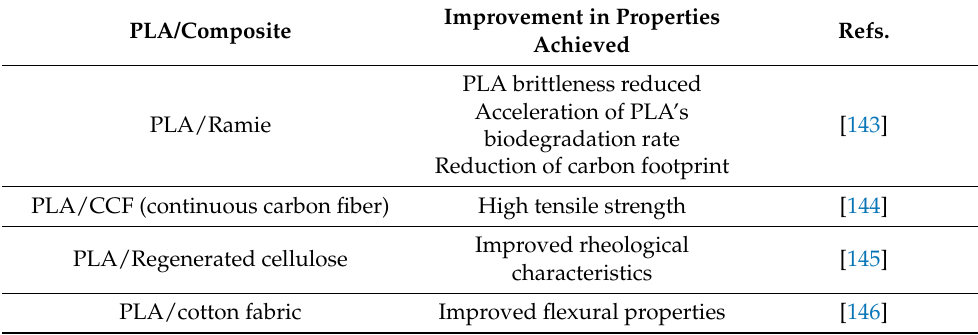
Table 3. PLA composites and the improvements in properties achieved in